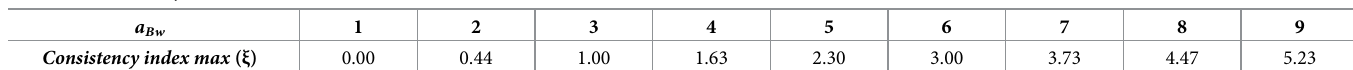
Table 5. Consistency index